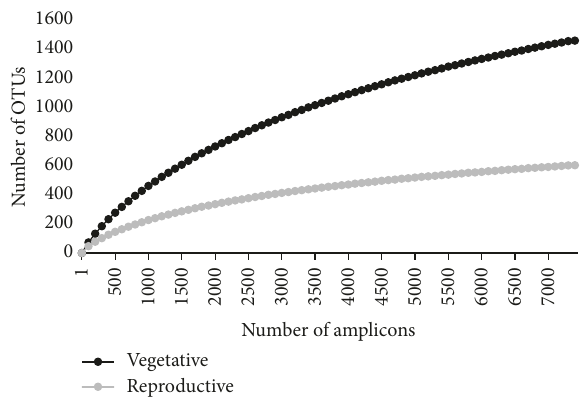
Figure7:Rarefactioncurvesgeneratedfrom16Sampliconssampled from floodwaters from vegetative and reproductive rice stages. Rarefaction curves were generated using the rarefaction.single command in mothur with freq=100 and